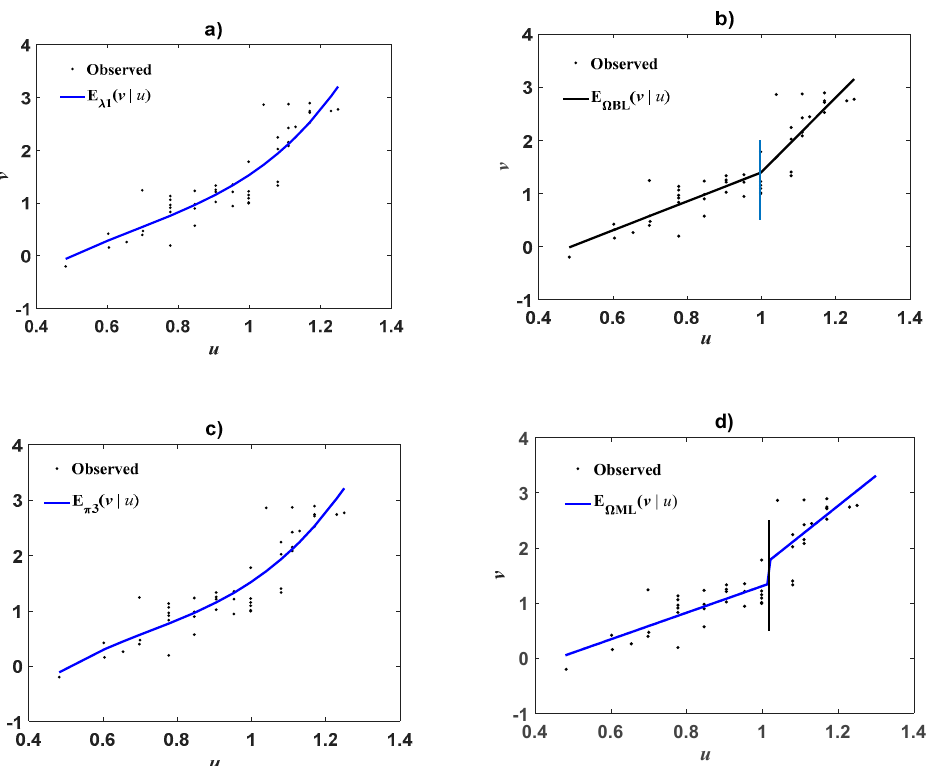
Figure 5. MCA proxies fitted in geometrical space for the Ramirez-Ramirez et al. [6] data. Panel ( a ) dispersion of response v about mean functions E λ 1 ( v | u ) . Panel ( b ) corresponding spreading